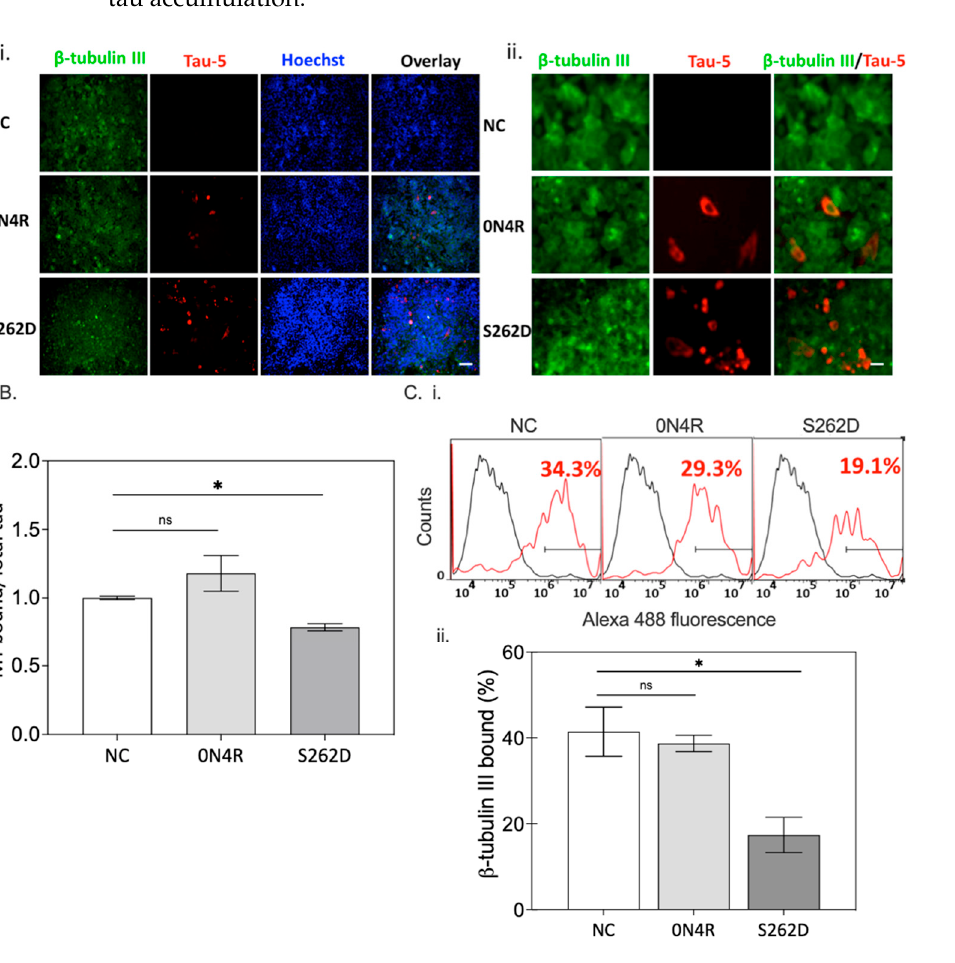
Figure 8. Ser262 phosphorylation alters tau cellular distribution and disrupts microtubule integrity. ( A ( i )) Representative fluorescent images of the neuronal marker, β -tubulin III (Green), and tau marker, Tau-5 (Red), expressed by CHO cells transiently transfected with wild-type 0N4R and S262D variant three days following transfection. Negative control (NC): CHO cells transfected with pCEP4 plasmid backbone. Scale bar = 100 µm. ( ii ). Co-staining of β -tubulin III and Tau-5 showed an overlap in cellular distribution decreased in CHO cells transfected with the S262D variant. Scale bar = 25 µm. ( B ) The amount of tau in the MT-bound fraction was normalized to total tau to get the relative tau binding affinity to microtubules for CHO cell lysates (* represents p < 0.05 between two different groups, n = 3; error bars represent SD; ns = not significant). ( C ) Cell lysates of CHO cells transfected with different constructs were processed for the in vitro microtubule binding assay (See materials and methods section). ( i ). Representative histograms of β -tubulin III by lysates of CHO cells transfected with different constructs, via flow cytometry. Black line: negative control; red line: Alexa 488 bound β -tubulin III + cell population. NC, CHO cells transfected with pCEP4 backbone. ( ii ). Quantification of β -tubulin III for all three groups 3 days post-transfection (* represents p < 0.05 between mean of different groups, n = 3; error bars represent SD; ns = not significant). 2.6. The Interplay between Ser262 Phosphorylation and GSK3 β Activity 2.6.1. Temporal Relationship between Ser262 Phosphorylation and Other Phosphoryla- tion Sites in Tau To understand the factors contributing to tau accumulation by Ser262 phosphoryla- tion, we evaluated the abnormal forms of tau by using immunohistochemistry with an AT8 antibody, which recognizes the phosphorylated Ser202 and Thr205 epitopes, and a phospho-Ser199 antibody (Figure 9A(i)) [12,36]. We found that cells transfected with S262D exhibited higher intensities of AT8+ cells and pS199+ cells than cells transfected with wild type 0N4R (Figure 9A(ii)), while non-transfected CHO cells (negative control, NC) showed negligible AT8 and pS199 immunoreactivities. Blocking the phosphorylation